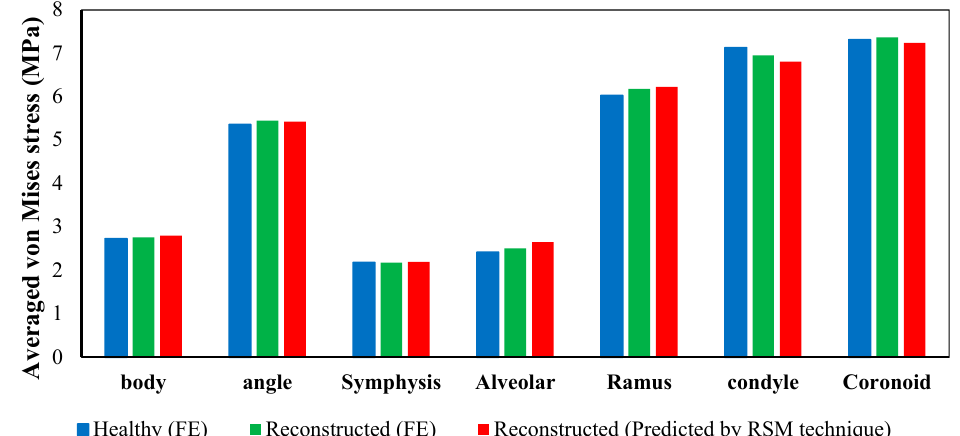
Figure 14. Average von Mises stress in different regions obtained from finite element analysis of a normal adult mandible, finite element analysis of reconstructed mandible, and predicated values for reconstructed mandible from the second order function estimated by RSM technique.